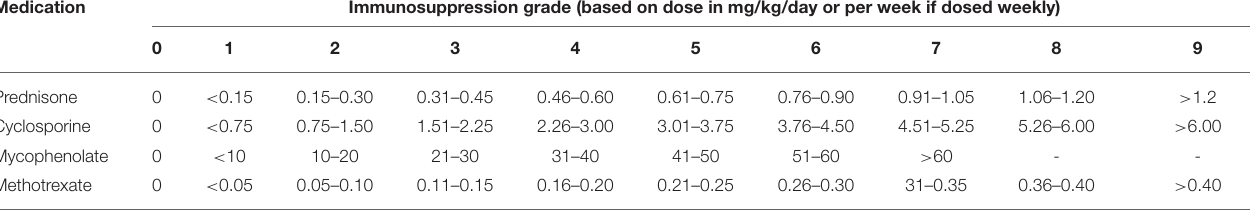
TABLE 1 | Grading scheme used to quantify immunomodulatory therapy (IMT) load. Medication